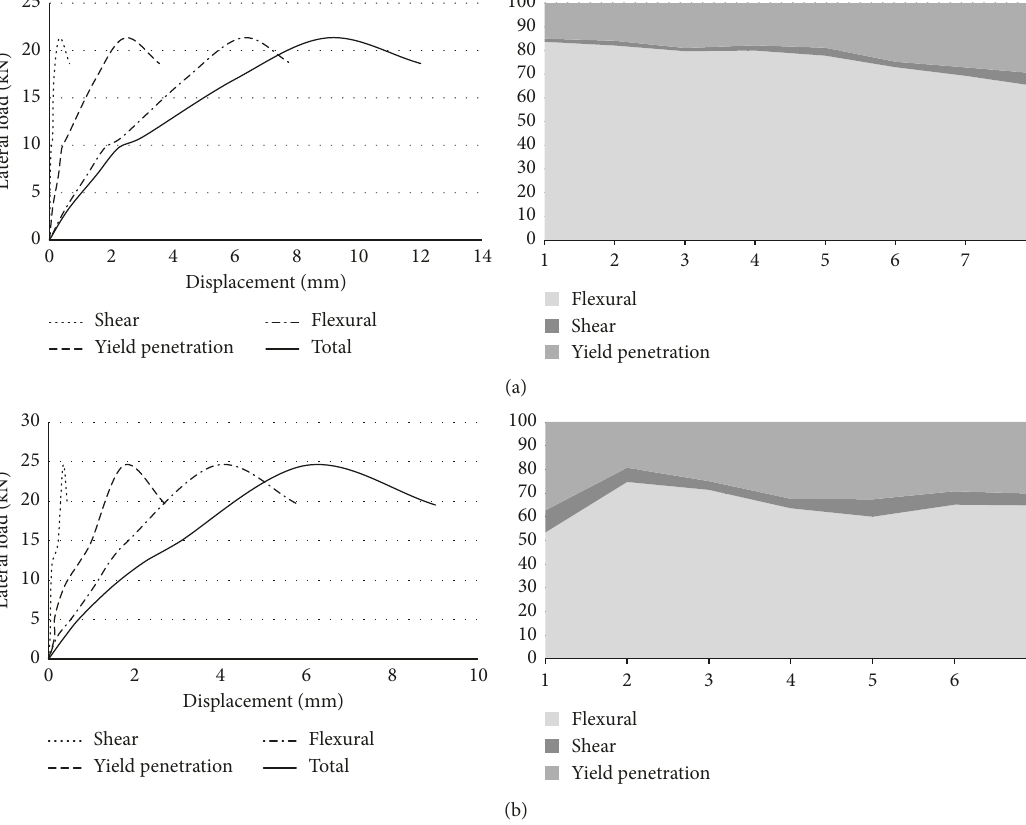
Figure 8: Variation of displacements due to flexure, shear, and yield penetration: axial load-deformation relationship (left) and ratio of each displacement to total displacement at each loading step (right). (a) RCW4 specimen. (b) RCW8